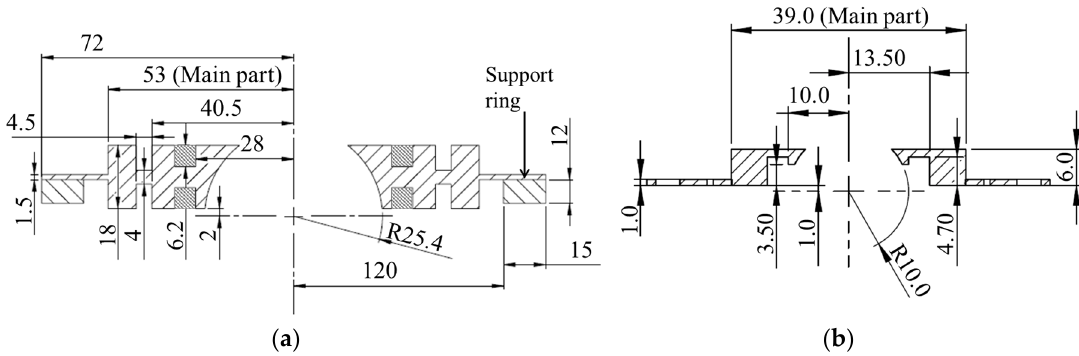
Figure 11. Dimensional drawings of stators designed for used in the MDOF-SUSM. ( a ) Prototype and ( b ) φ 20 mm type.